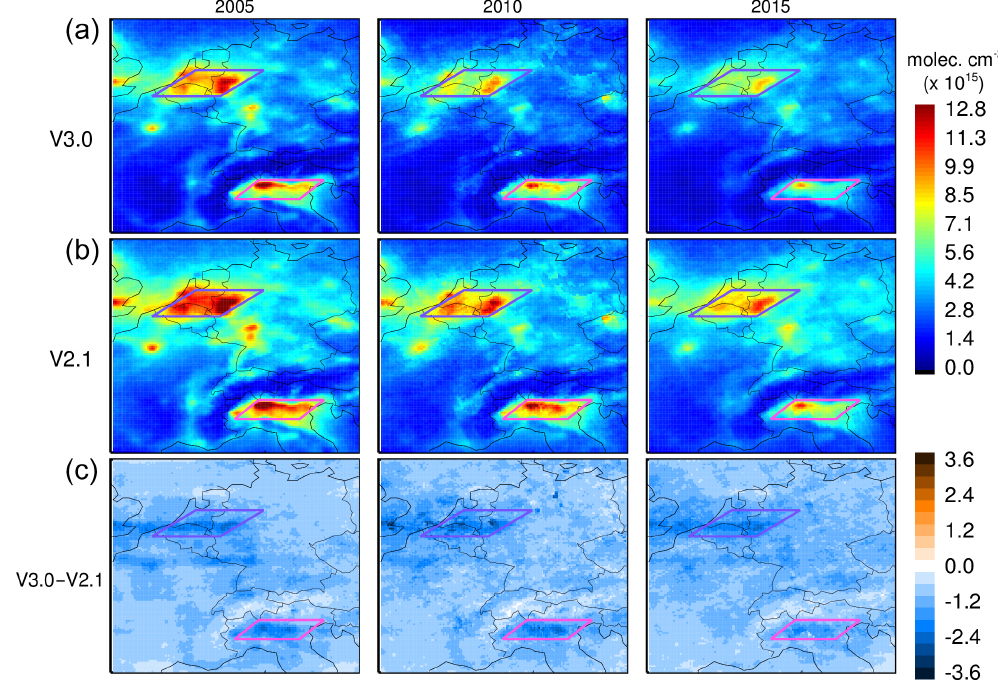
Figure 7. OMI SP V3 (a) and V2 (b) and difference V trop maps over western Europe for 2005, 2010, and 2015. The boxes outline the densely populated and industrialized regions in the southwest Netherlands, northwest Belgium, and Westphalia in Germany (blue box: Randstad-Ruhr in Fig. 6), and in the industrial Po River valley in northern Italy (red box: Po Valley in Fig. 6).